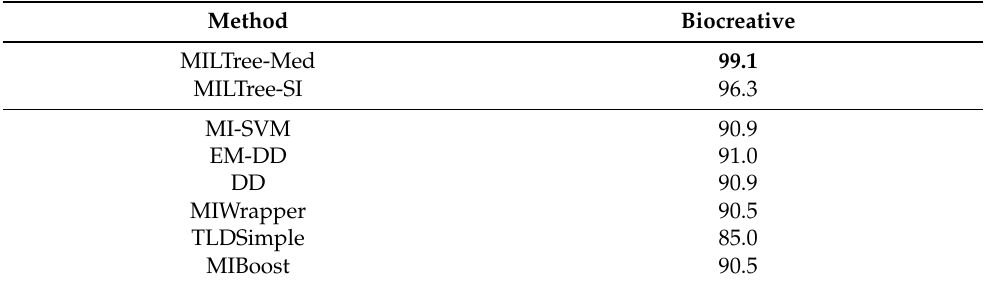
Table 10. Comparison of classification accuracy between MILTree-SI/MILTree-Med and baseline methods on the Biocreative dataset.